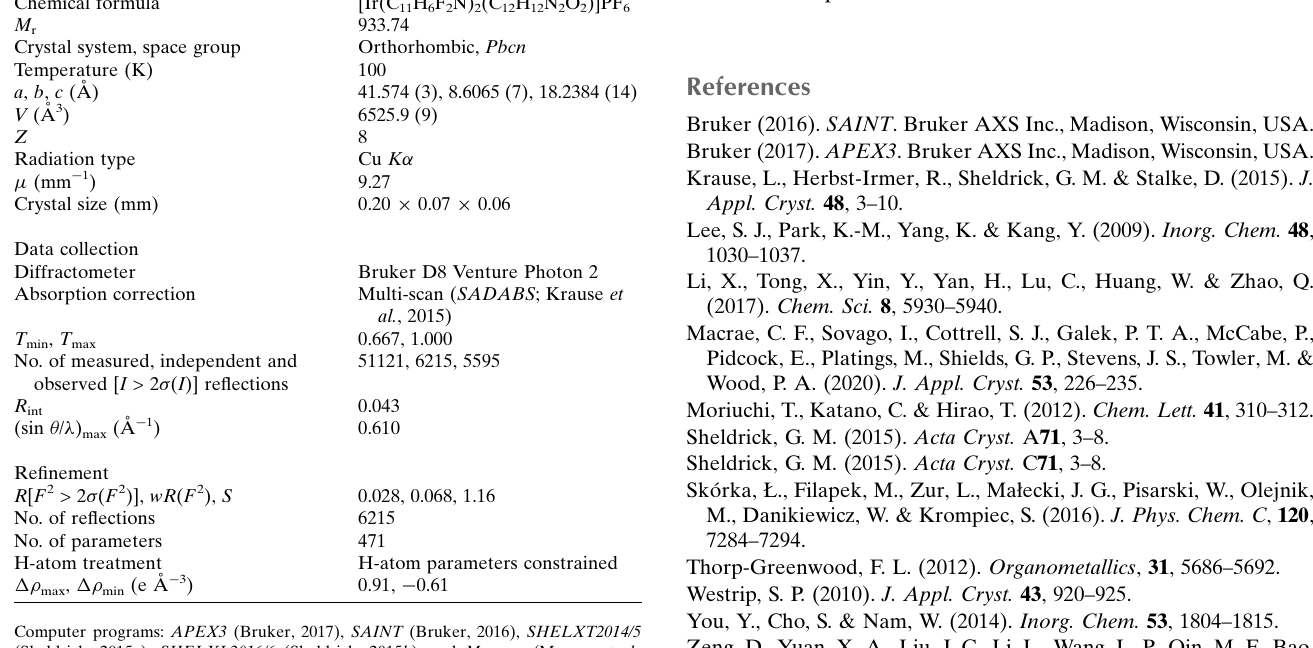
Table 2 Experimental details. Crystal data Chemical